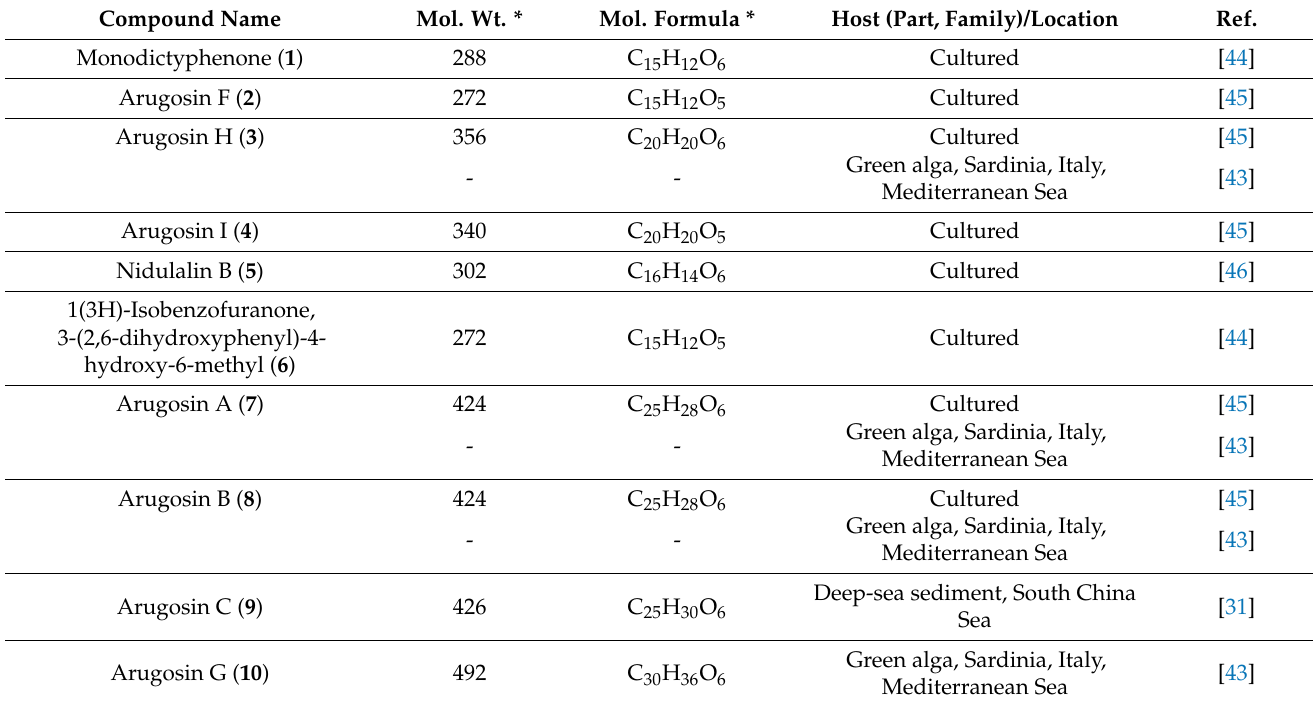
Table 2. Benzophenones reported from Aspergillus nidulans